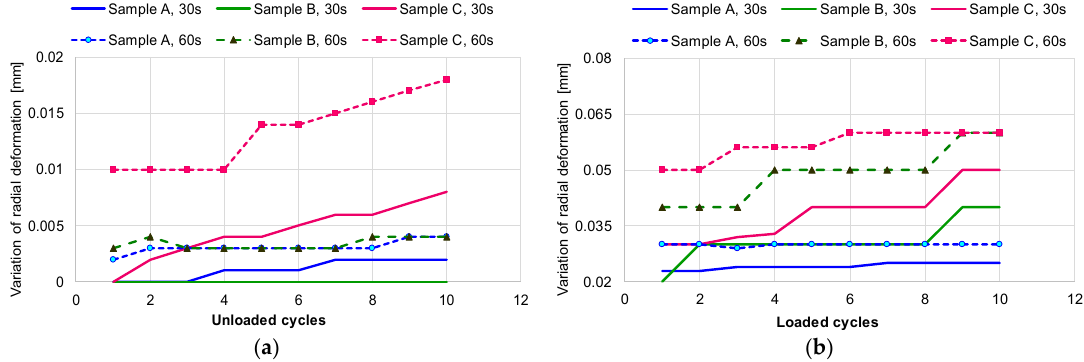
27.220 * p active denotes during pressure loading, and p inactive denotes during unloading. ( a ) ( b ) (c) Figure 11. Cyclic variation of exterior diameters of tested samples: ( a ) Sample A; ( b ) sample B; ( c ) sample C. The trend line of radial deformation with increasing cycle number and duration of exposure to internal pressure is presented in Figure 12. In all cases, the deformation does not exceed 0.02 mm for all exterior diameters (Figure 12a). With decreasing wall thickness of the mini pipes, the residual strain increased both in the case of the 30 s and 60 s loading cycles, but with different values, in accordance with the ratio between exterior and interior diameter, β , as can be seen in Figure 12a,b. The authors of [18] remarked that when the pipe is loaded elastic–plastically, a negligible increase of inner pressure caused a substantial increase of the elastic–plastically deformed zone. The variation of radial deformation at loading and unloading leads to increased plastic behaviour. In this situation,